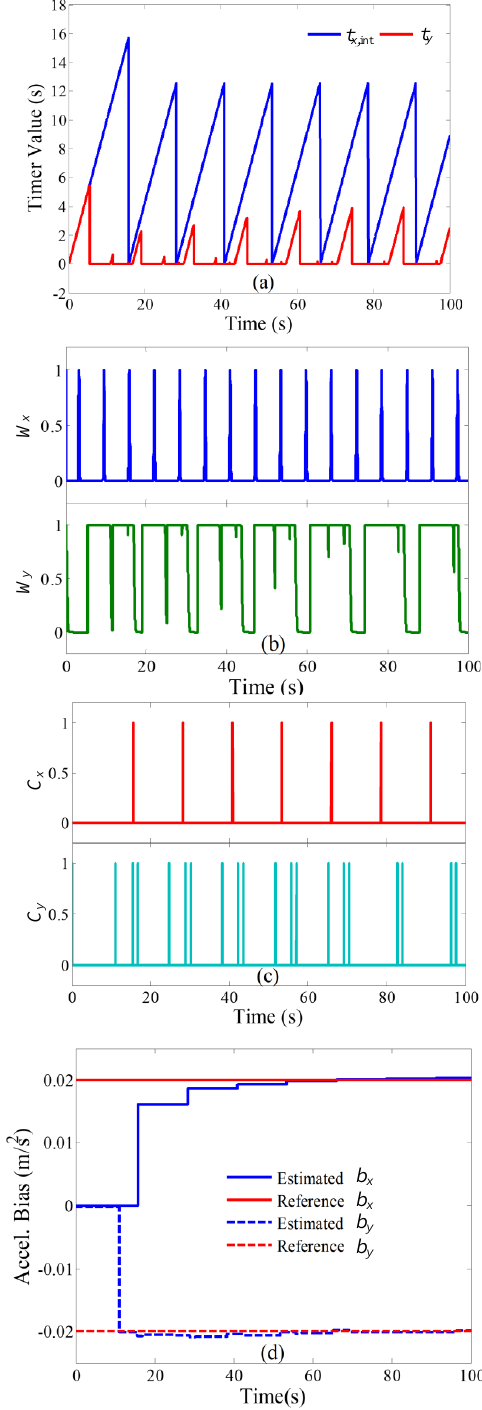
Figure 9. Intermediate estimation results during the consecutive DLC test: ( a ) integral timers; ( b ) weighting factors for DEC ( c ) triggering factors for ABE; ( d ) acceleration biases.